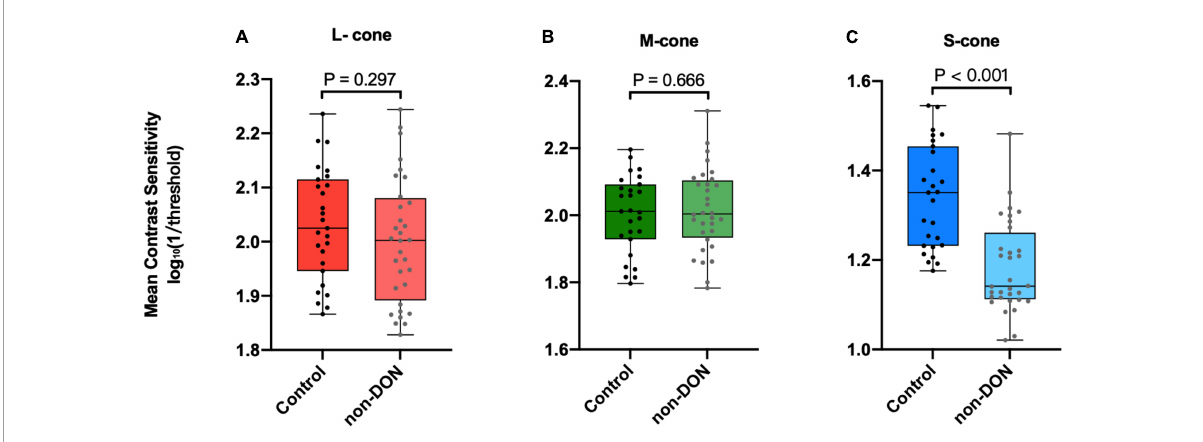
FIGURE3 Contrast sensitivities to L- (A) , M- (B) , and S-cone (C) Gabors of the control and non-DON group.